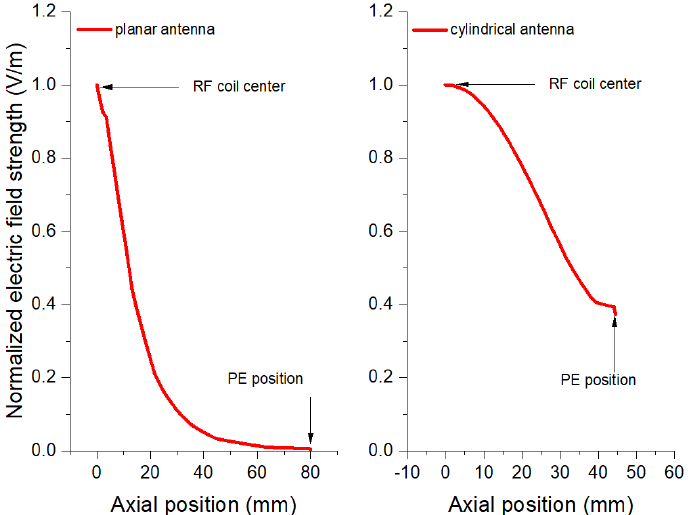
Figure 2. RF electric field distribution along the axial position.